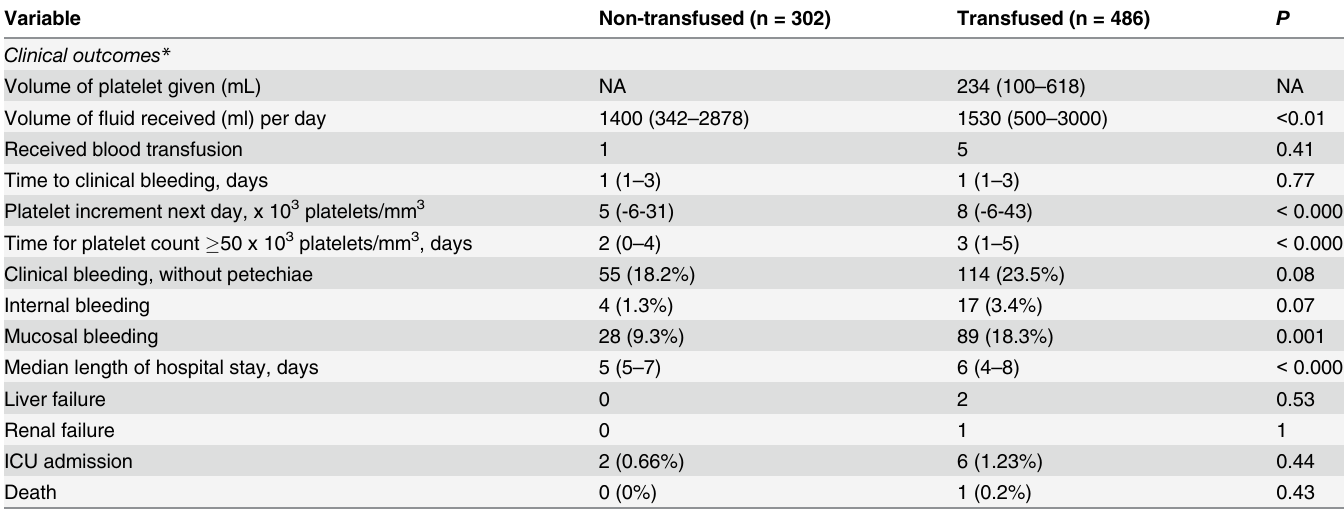
Table 2. Clinical outcomes of cohort.